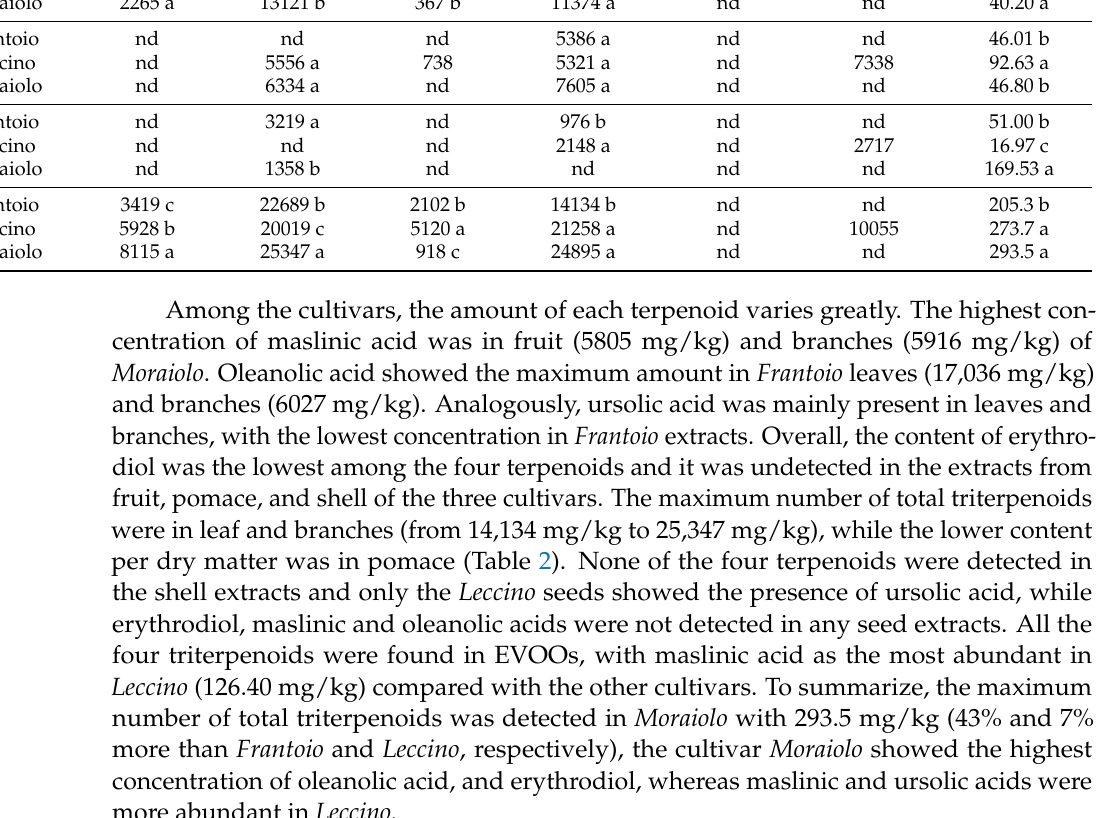
such as leaves and branches. All the four triterpenoids were found in EVOOs. Table 2. Distribution of maslinic acid, oleanolic acid, ursolic acid and erythrodiol in all the extracts from the three Tuscan varieties determined by HPLC-DAD. For each molecule, different letters indicate different contents among cultivars. mg/kg Triterpenoid. cv Fruits Leaves Pomace Shell Seeds Oil (rt, min) Maslinic acid